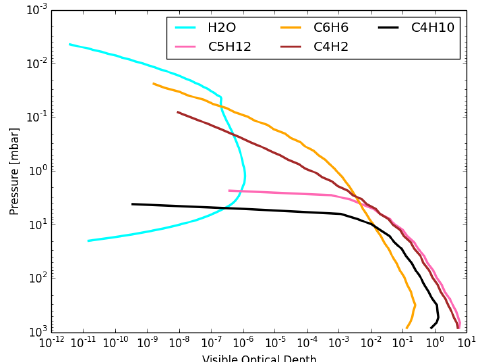
Figure 5. Geometric limit optical depth (per layer) of the ice particles formed in Saturn’s atmosphere. Water ice particles can form from either homogeneous nucleation or heterogeneous nucleation onto involatile haze particles. Both types of particles then serve as condensation nuclei for the trace hydrocarbons